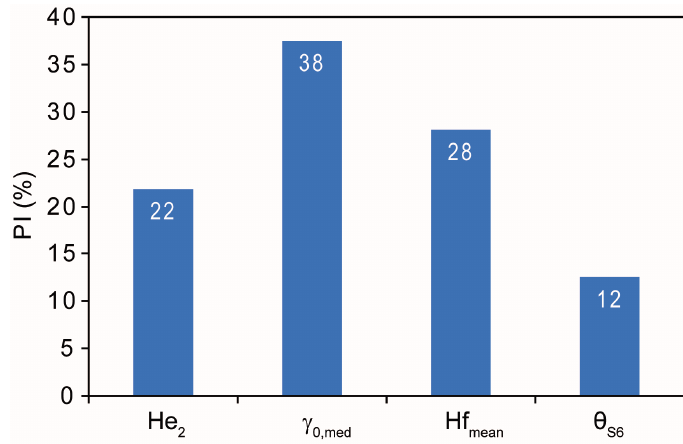
Figure 8. The predictor importance ( PI ) values calculated from D2 modeling